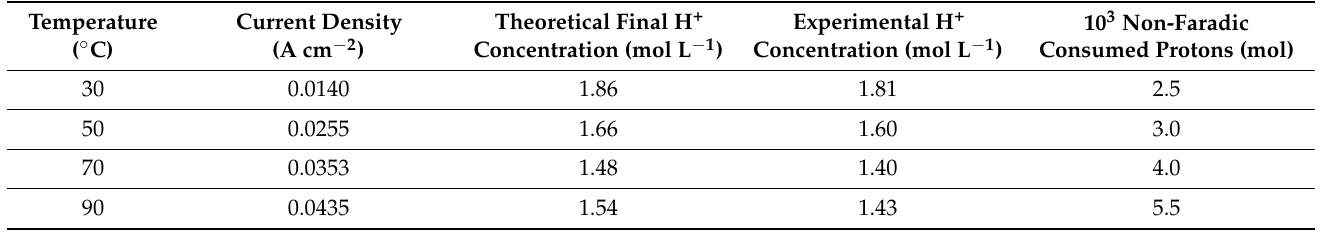
Table 4. Comparison between the real and theoretical proton concentration according to Faraday’s